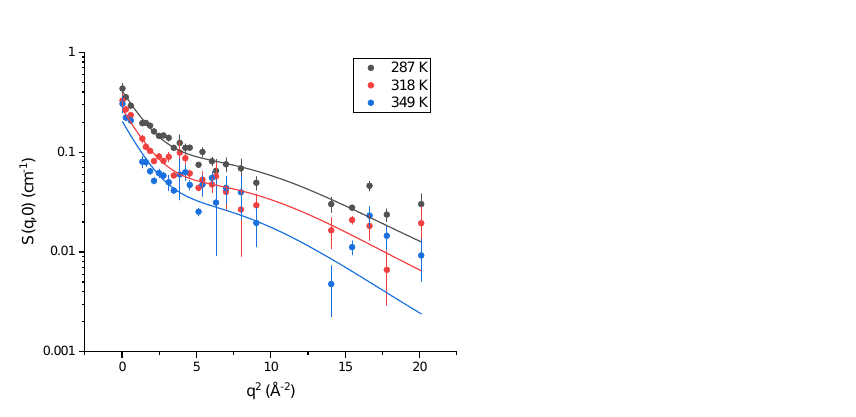
Figure 3. Scattering curves for Tba PMI at 150 bar and at some representative temperatures, with the corre- sponding two-state model fits. The decrease of the elastic intensity with temperature is expected, as more motions enter the time window of the experiment and the involved atoms scatter neutrons inelastically. Data have been interpreted in the framework of a two-state model [31], which assumes two harmonic potential wells with an associated Mean Square Displacement (MSD) ∆ x 2 , 0 separated by a distance d and a free energy ∆ G = ∆ H − T ∆ S (see Methods). The tem- perature independence of d (Figure S10), ∆ H and ∆ S (consistently with the assumed Arrhenius behaviour of the two wells’ populations) allowed the employment of a global fitting procedure at each pressure point, in which the only temperature-dependent pa- rameter was ∆ x 2 . This granted the minimization of the number of free fitting parameters 0 and greatly improved the quality and stability of the fittings. Figure 4 shows, for both = ∆ x 2 + p 1 p 2 d 2 , which takes samples, the single-well MSD, ∆ x 2 , and the total MSD, ∆ x 2 tot 0 0 3 into account the jump distance between the two wells and their populations. The absolute values of ∆ x 2 , which report on the amplitude of the internal motions, appear very similar tot for both samples around 350 K, indicating that the proteins display a similar degree of flexibility in proximity of the optimum growth temperature for both organisms. However, the two samples show a clearly different temperature dependence of the MSD, i.e., the slope of the curve which is inversely proportional to the protein’s resilience [32,33]: while Tko PMI displays a smooth increase, a change of slope in Tba PMI at around 320 K and 1 bar evidences the lower resilience, i.e., higher softness , of the protein. This transition is not present at higher pressures, and a linear temperature dependence of the MSD is observed.